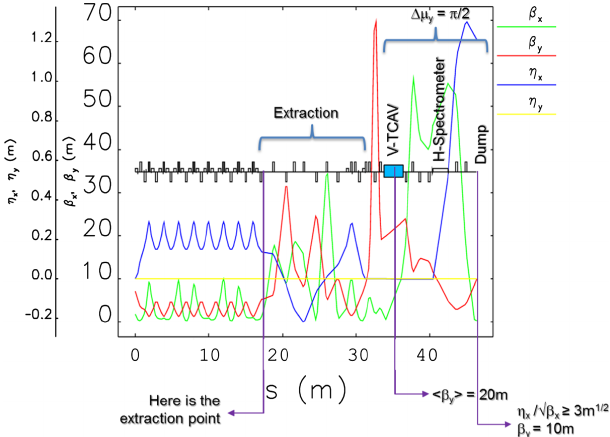
FIG. 7. Linear optics functions along the CA and the diagnostic branch line; the beam moves from left to right. The position of elements along the lattice and optics constraints for optimum diagnostic resolution is shown. The transport matrix for the horizontal and vertical betatron motion of the line portion, labeled “ Extraction ” in the figure, is the 4 × 4 identity matrix indicated in Fig. 6.